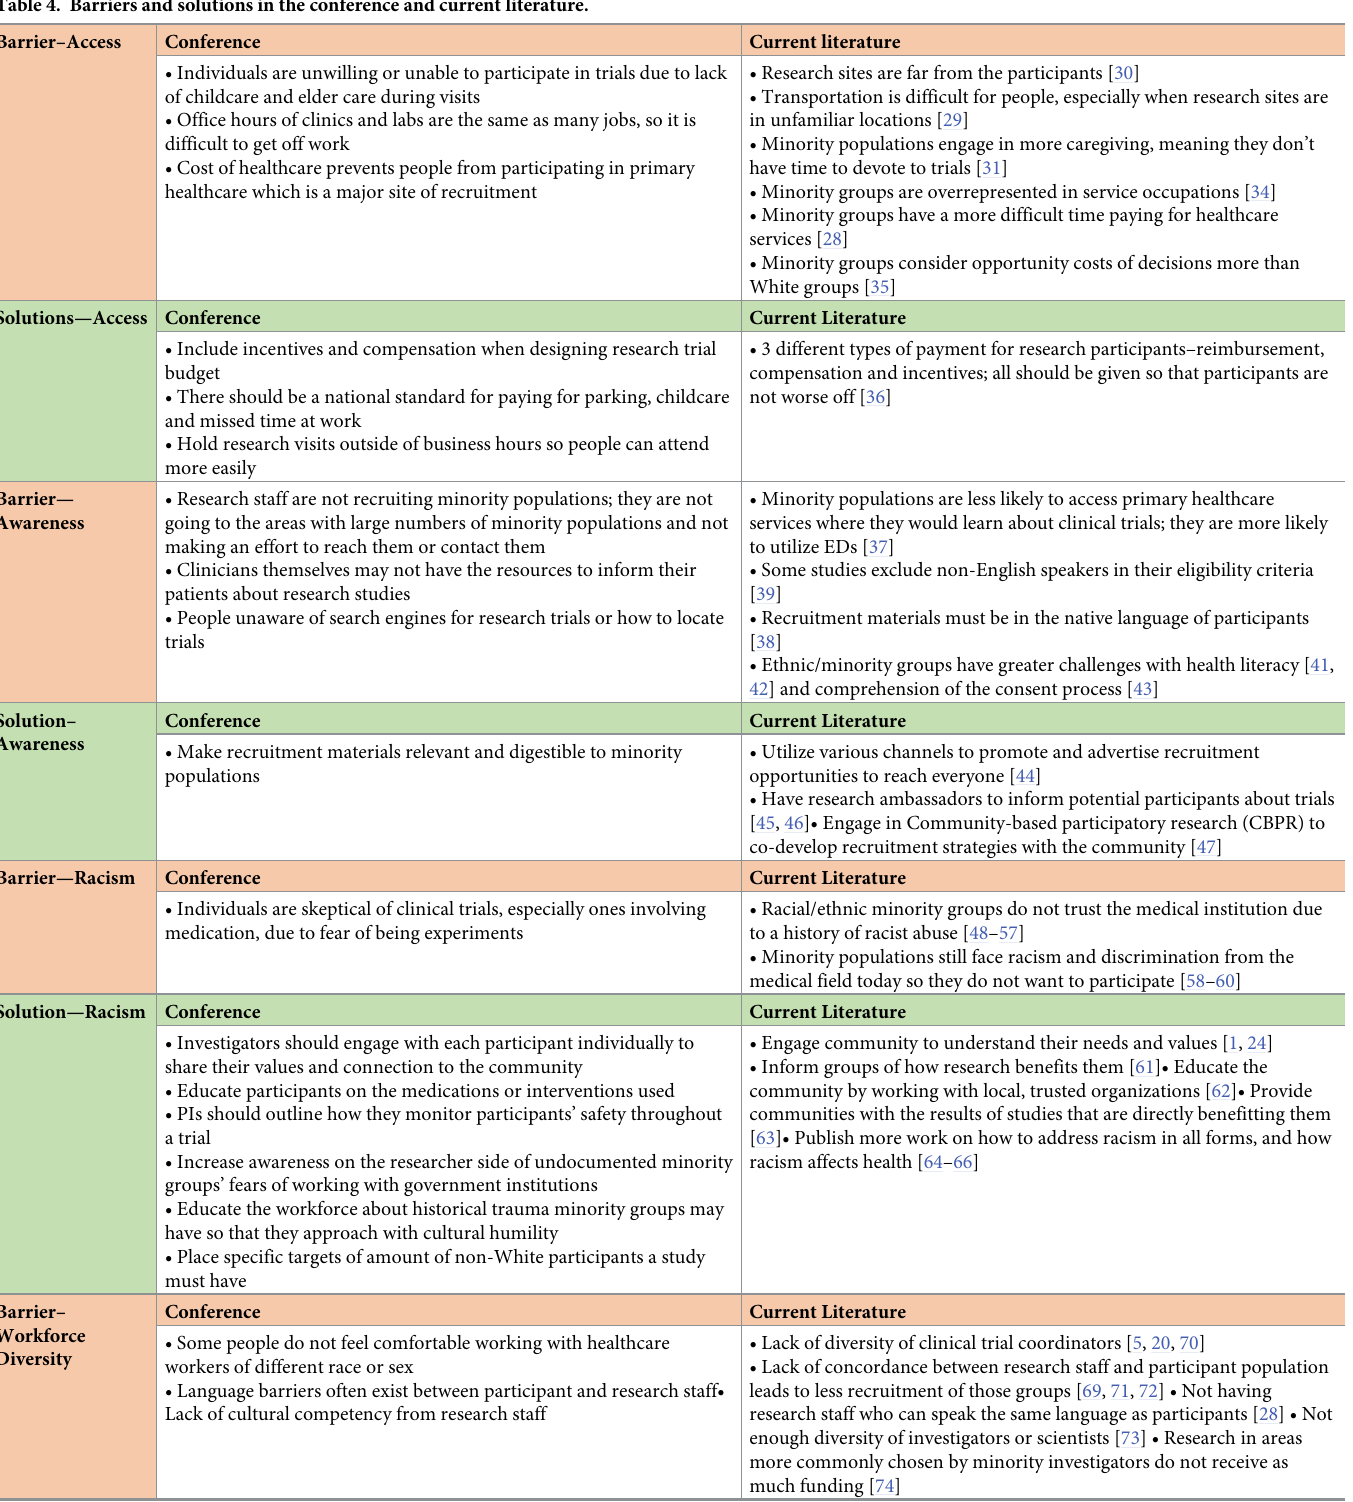
Table 4. Barriers and solutions in the conference and current